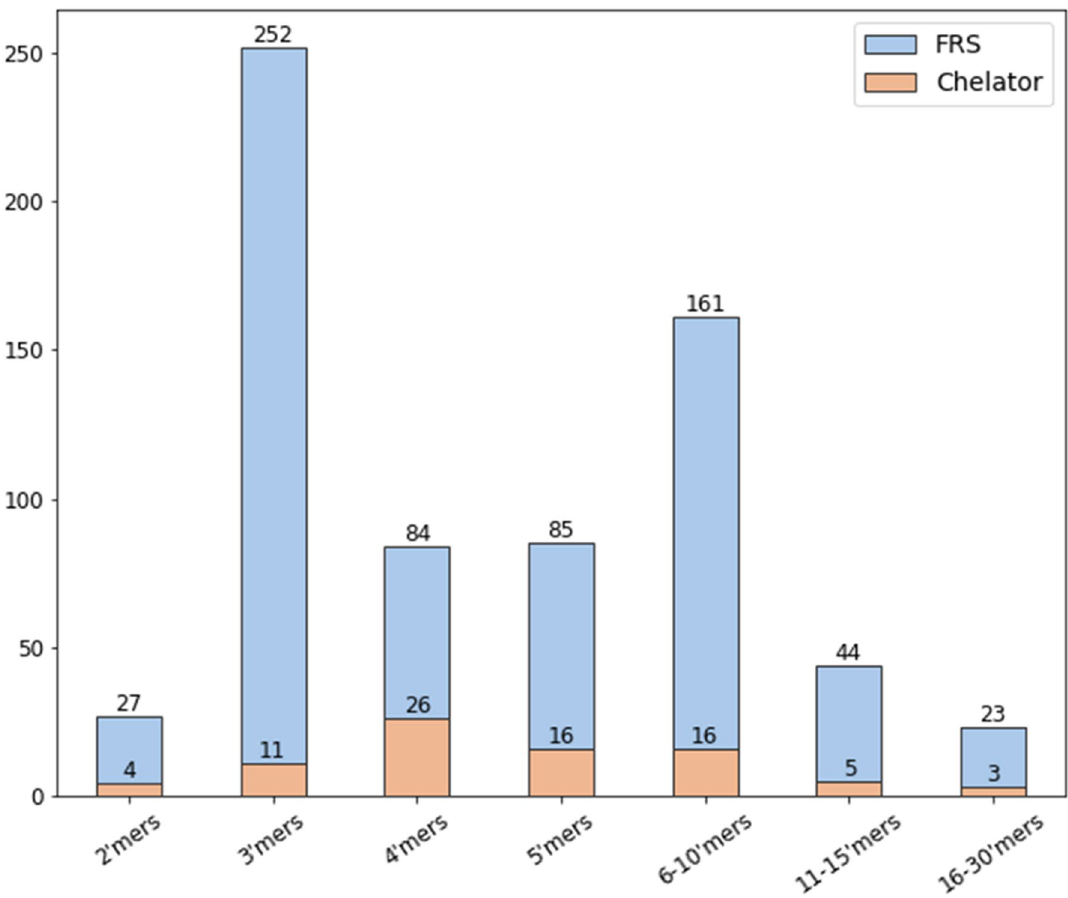
Figure 2. Overview of the properties and length of peptides in the benchmark dataset. FRS free radical